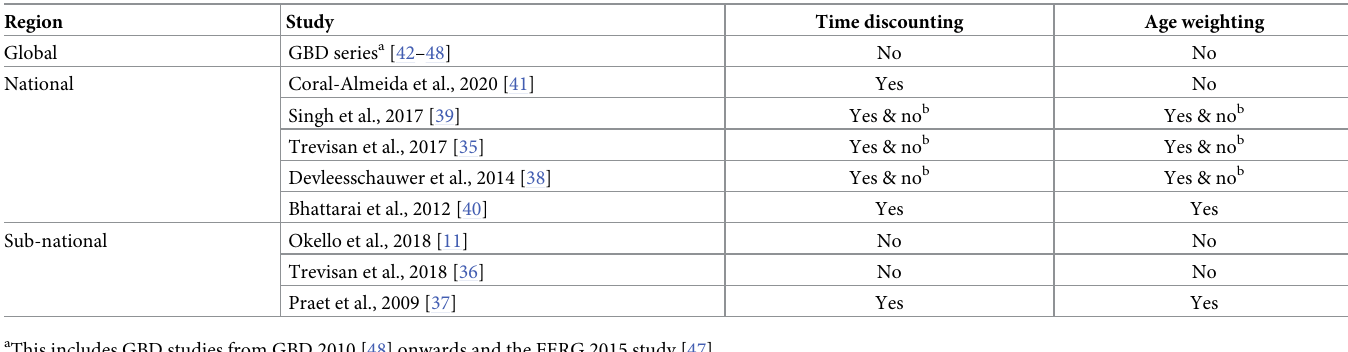
Table 3. A summary of time discounting and age weighting